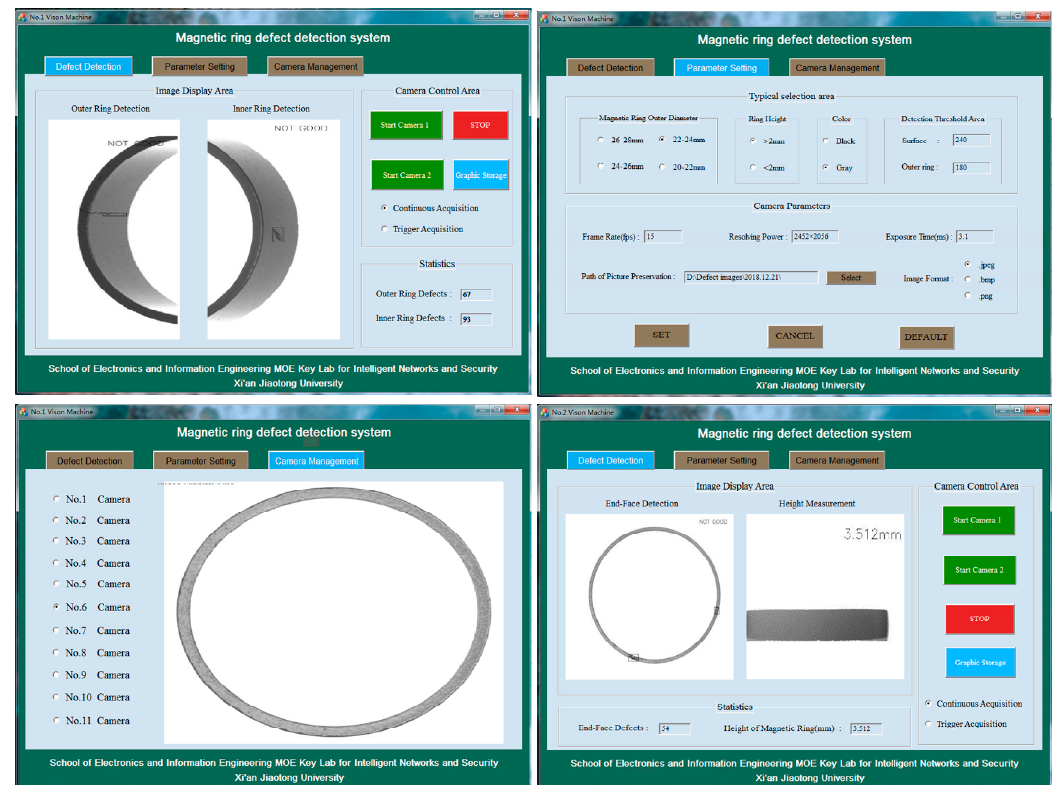
Figure 5. Flowchart of the software system.